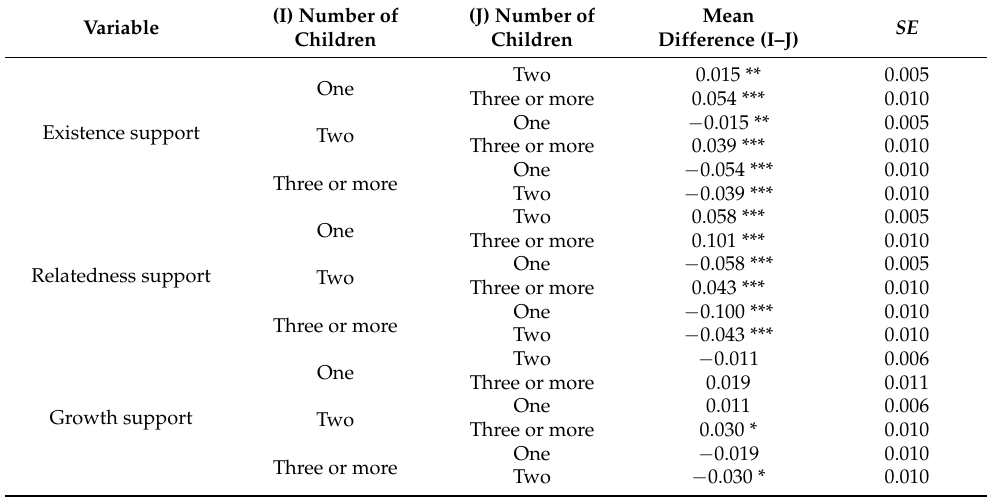
Table 1. Comparison of family support for infant and toddler care with different number of children.